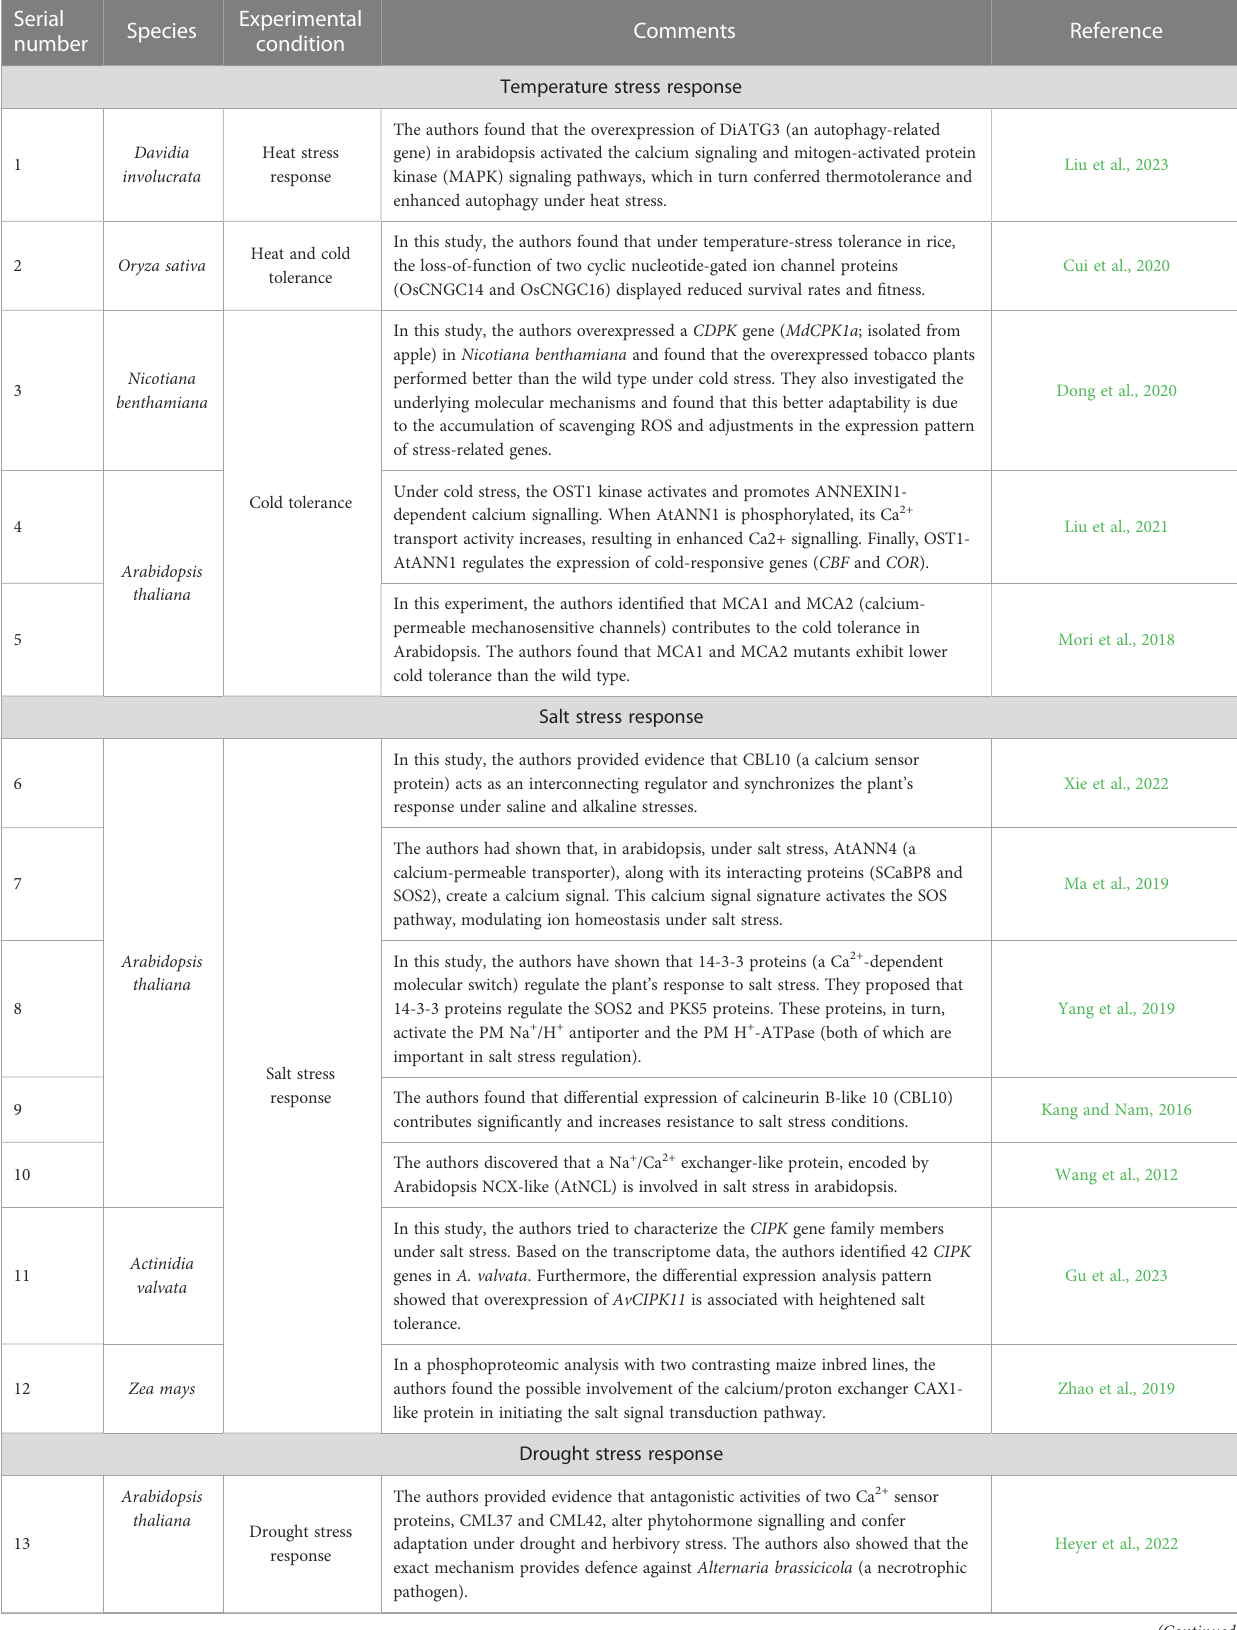
TABLE 1 Some important Ca 2+ signalling in abiotic stress-speci fi c research works identi fi ed in major plant